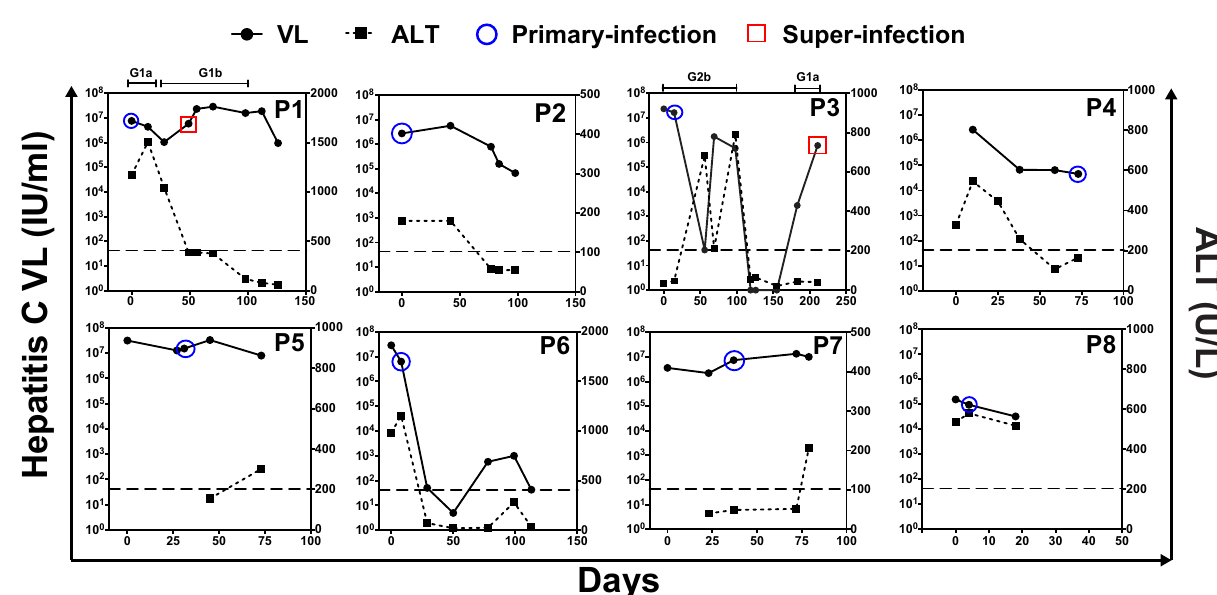
Fig 1. Evolution of ALT and hepatitis C virus (HCV) RNA levels and samples selected for single genome sequencing (SGS) after clinical onset of acute HCV infection among eight HIV-infected men who have sex with men. HCV RNA levels (log 10 IU/mL) (dots) are plotted against the left y-axis; ALT levels (U/L) (filled squares) are plotted against the right y-axis; and time (weeks) from clinical onset of HCV infection is plotted on the x-axis. All available measurements during the sampling period are shown. The samples analyzed using SGS from the primary HCV infections are shown by a blue circle around the corresponding HCV VL point. The samples analyzed using SGS from the HCV superinfections (P1 and P3 only) are shown by a red square around the corresponding HCV VL point. The bars above the plots for P1 and P3 show the duration of the viremia from the primary and superinfections, labeled by their genotype. SGS, single genome sequencing; P, participant; RNA, ribonucleic acid; IU, international units; mL, milliliter; ALT, alanine aminotransferase; G1a, genotype 1a; G1b, genotype 1b; G2b, genotype 2b.